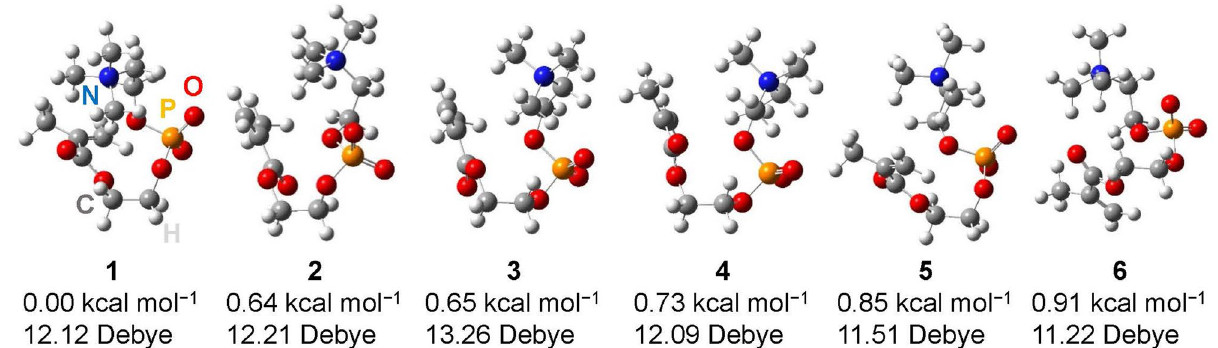
Figure 7. Six most stable conformers 1 – 6 common to solvents of ε = 8.33 and 15.20 at the B3LYP/6- 311++G(d,p) level. The relative energies from conformer 1 and the dipole moments of each conformer are the results with dielectric constant ε = 15.20 and without dielectric constant, respectively, at the B3LYP/6- 311++G(d,p) level.